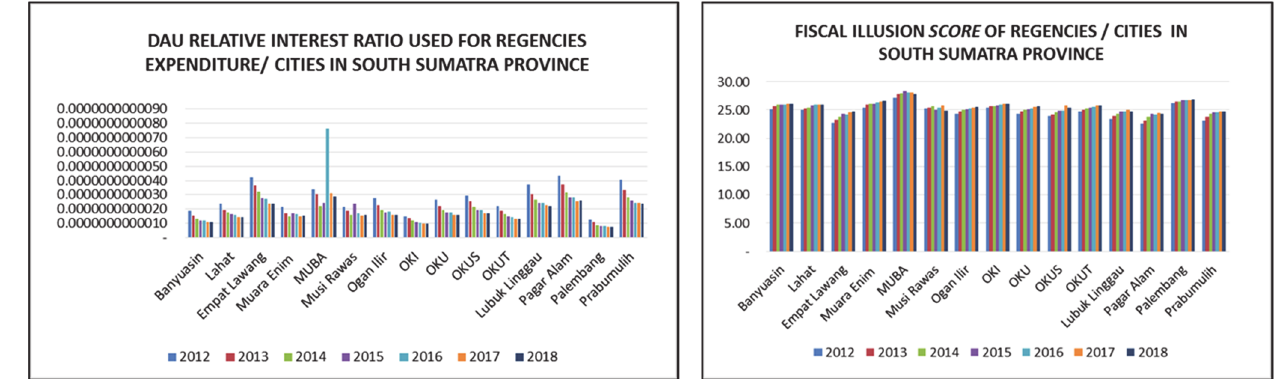
Fig. 5. DAU Relative Interest Ratio Used for Regencies Expenditure/ Cities in South Sumatra Province